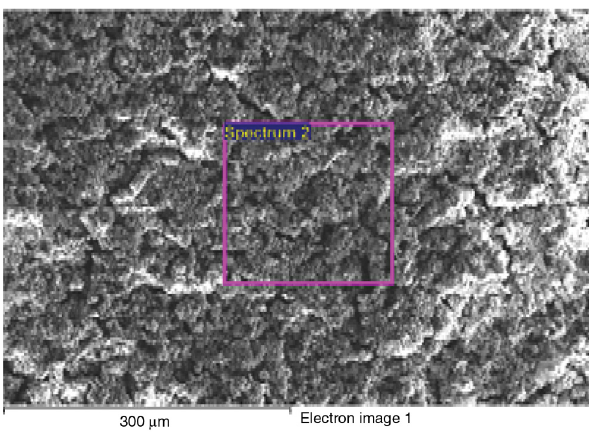
Figure 4: FE-SEM image of Crumb Rubber.